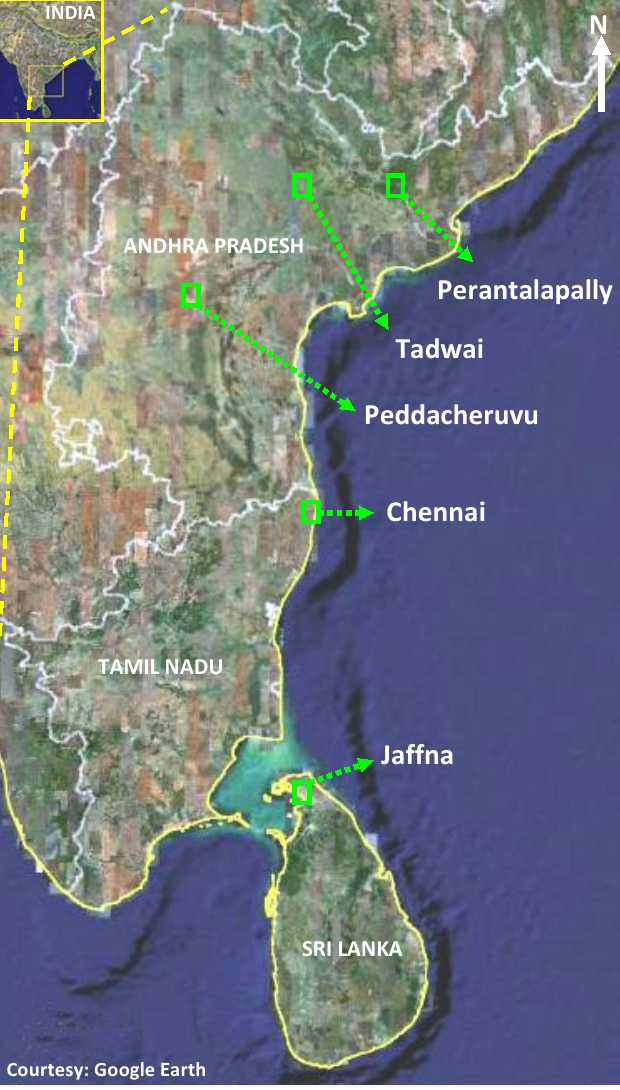
Image 1. Satellite image showing map (not to scale) depicting three distribution sites of whip-scorpion Thelyphonus sepiaris (Butler 1873) in the Eastern Ghats of Andhra Pradesh, India